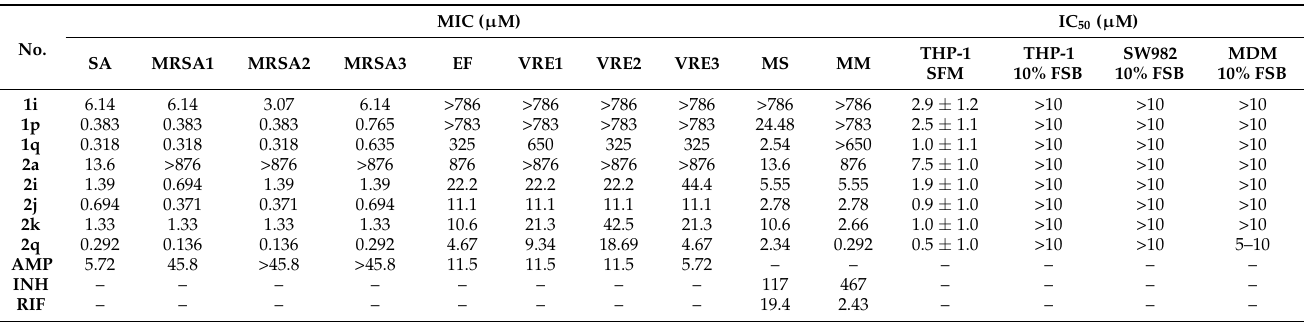
Table 2. In vitro antistaphylococcal, antienterococcal activities (MIC [ µ M]) compared to